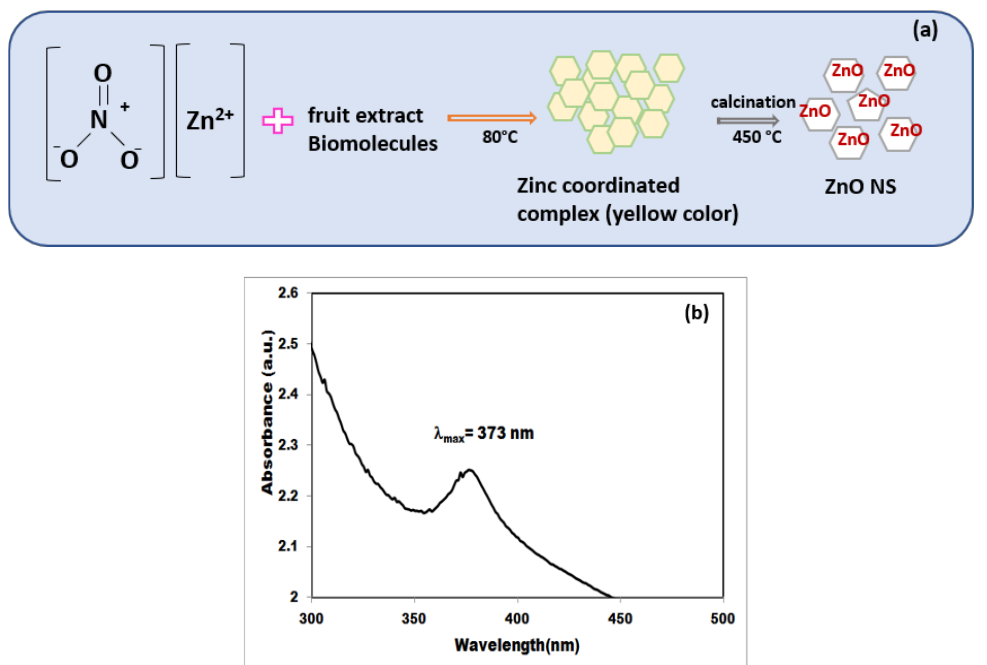
Figure 1. Schematic representation of zinc oxide nanostructures synthesis using Pyrus pyrifolia fruit extract ( a ). UV-Vis spectrum of the synthesized zinc oxide nanostructure solution ( b ).